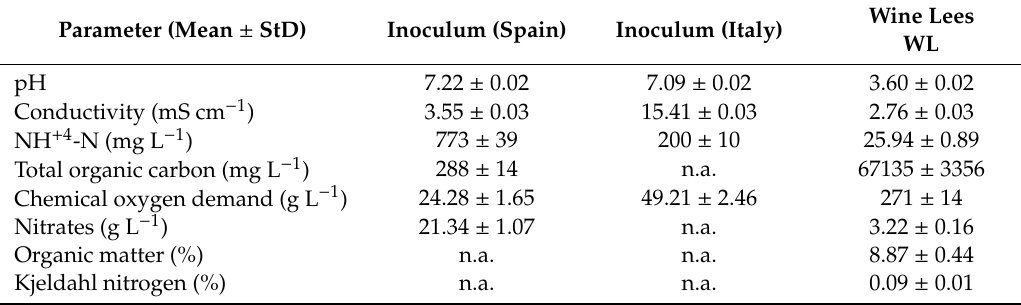
Table 2. Characterisation of inoculums and substrate used in batch digestion